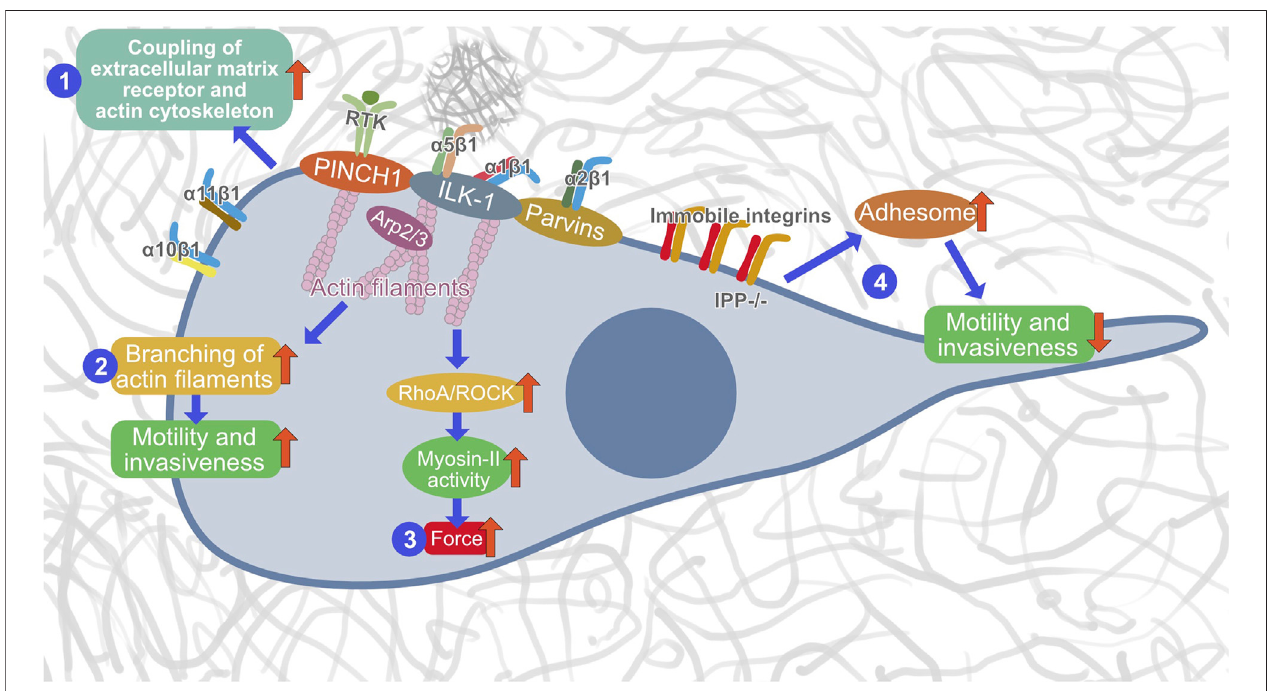
FIGURE9 | Hypotheticalmodel ofhow PINCH1 acts in theIPP complex. There are three distinct functions ofPINCH1, such asactin polymerization(1), generation of contractile forces (2) and promoting migration and invasion (3) through Arp2/3 driven branching of actin fi laments. In the absence of an IPP complex, the integrins become immobile, the adhesome is strengthened and the migration and invasion capacity is reduced